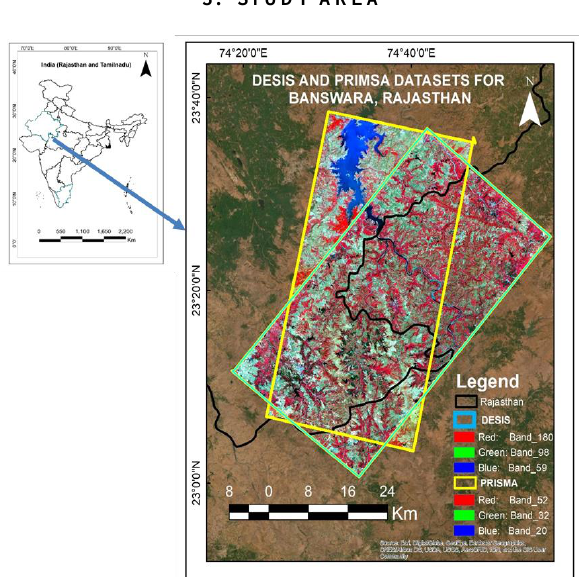
Figure 1. Study area- Banswara district of Rajasthan and